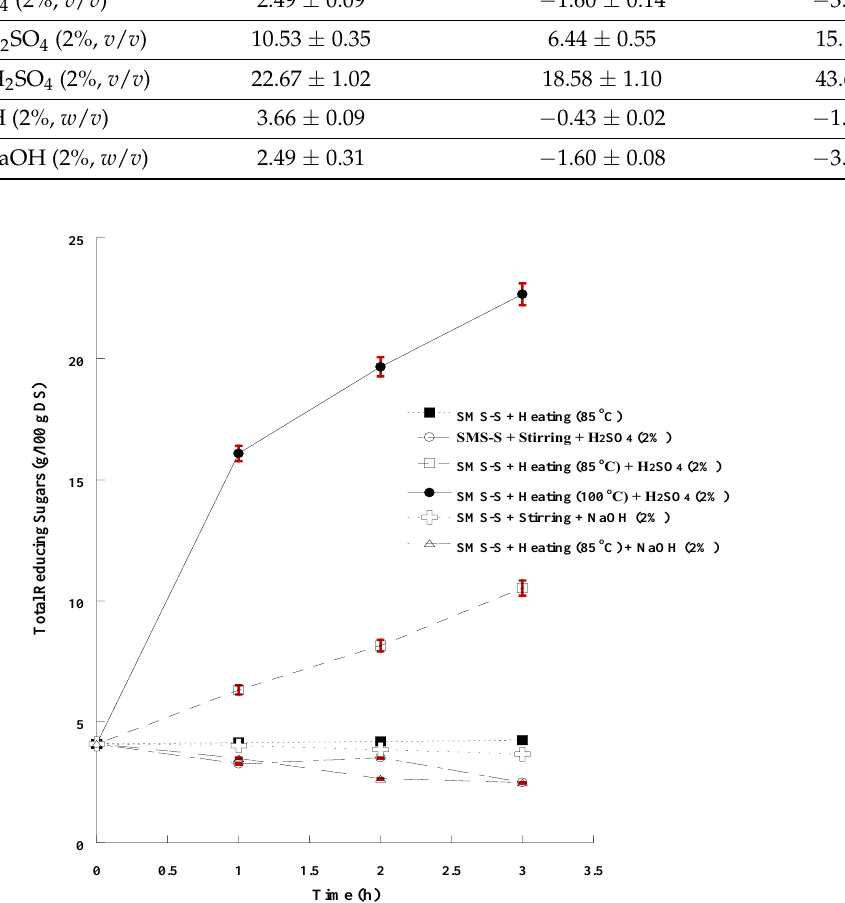
Figure 2. Monitoring the progress of SMS hydrolysis by determining the concentration of total re- ducing sugars in 3-h long processes. The presented results are the mean of two independent anal-